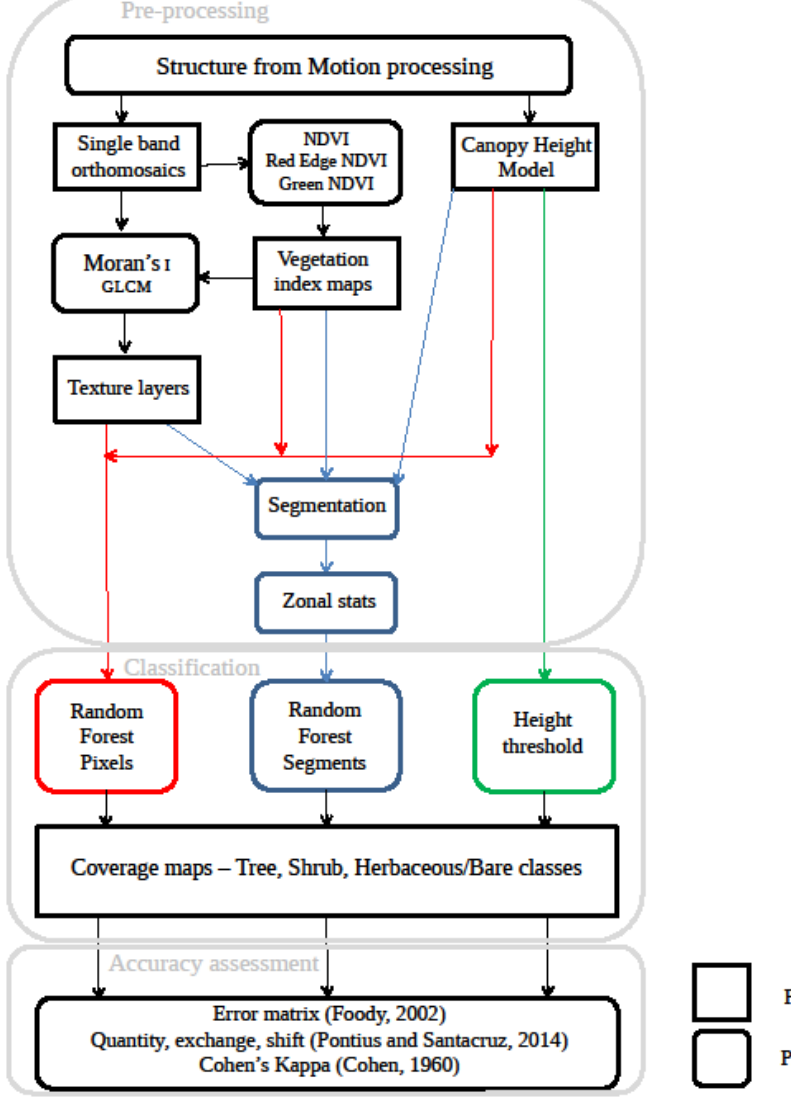
Figure 2. Process flow outlining data input, UAS-extracted metrics for segmentation, and the three different methods for classification: height threshold (green), RF pixel (orange), and RF segments (blue).